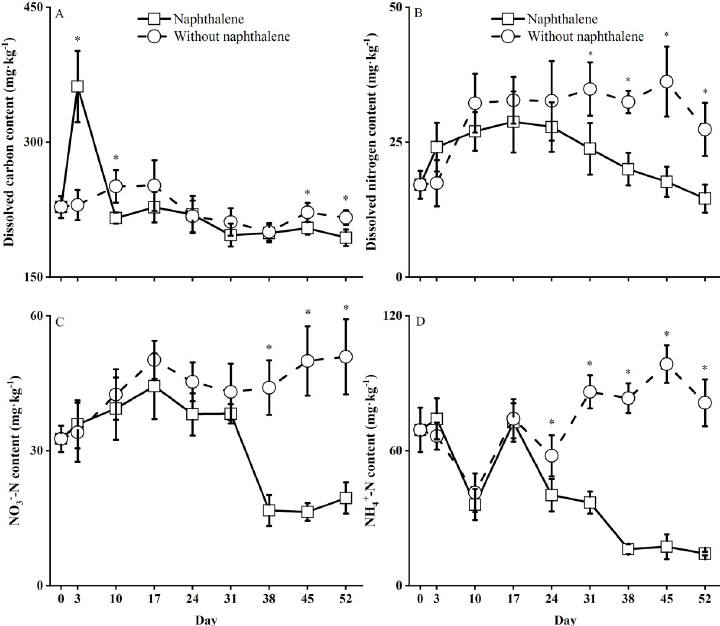
Fig 4. Soil dissolved organic matter and extractable N contents in subalpine forest soil microcosms treated with and without naphthalene. The values represent the means ± the standard error (SE) (n = 5). Asterisks indicate significant ( � P < 0.05) differences between the treatments with naphthalene and without naphthalene at the same sampling